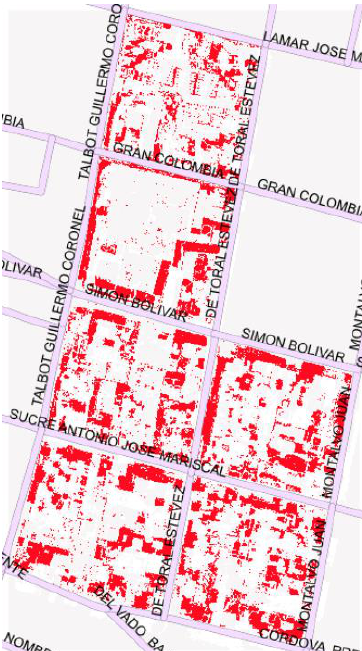
Figure 5: Location of traditional tile roofs structures, in different parcels in